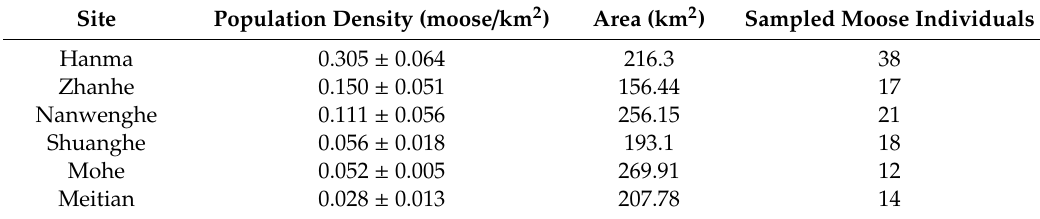
Table 1. Population density ± SE calculated with the spatially explicit capture recapture method in